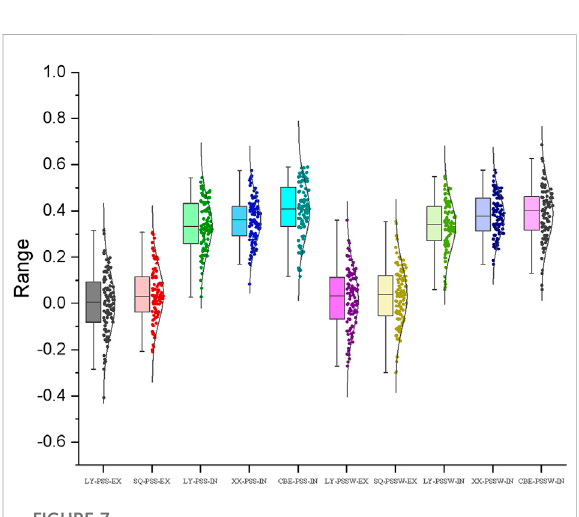
FIGURE 7 Genomic prediction (GP) accuracies for FHB resistance estimated from the fi ve-fold cross-validation schemes with the genome-wide markers by ex-vivo (EX) and in-vivo (IN) inoculation treatments in Luoyang (LY), Xinxiang (XX), and Shangqiu (SQ) locations assessed by PSS and